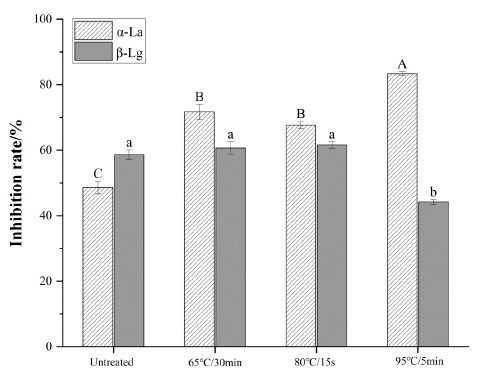
Figure 4. Effects of different sterilizations on the binding capacity of major allergens and specific IgE in WPI. Different uppercase letters indicate significant differences in α -LA after different treatments ( p < 0.05). Different lowercase letters indicate significant differences in β -LG after different treatments ( p < 0.05).